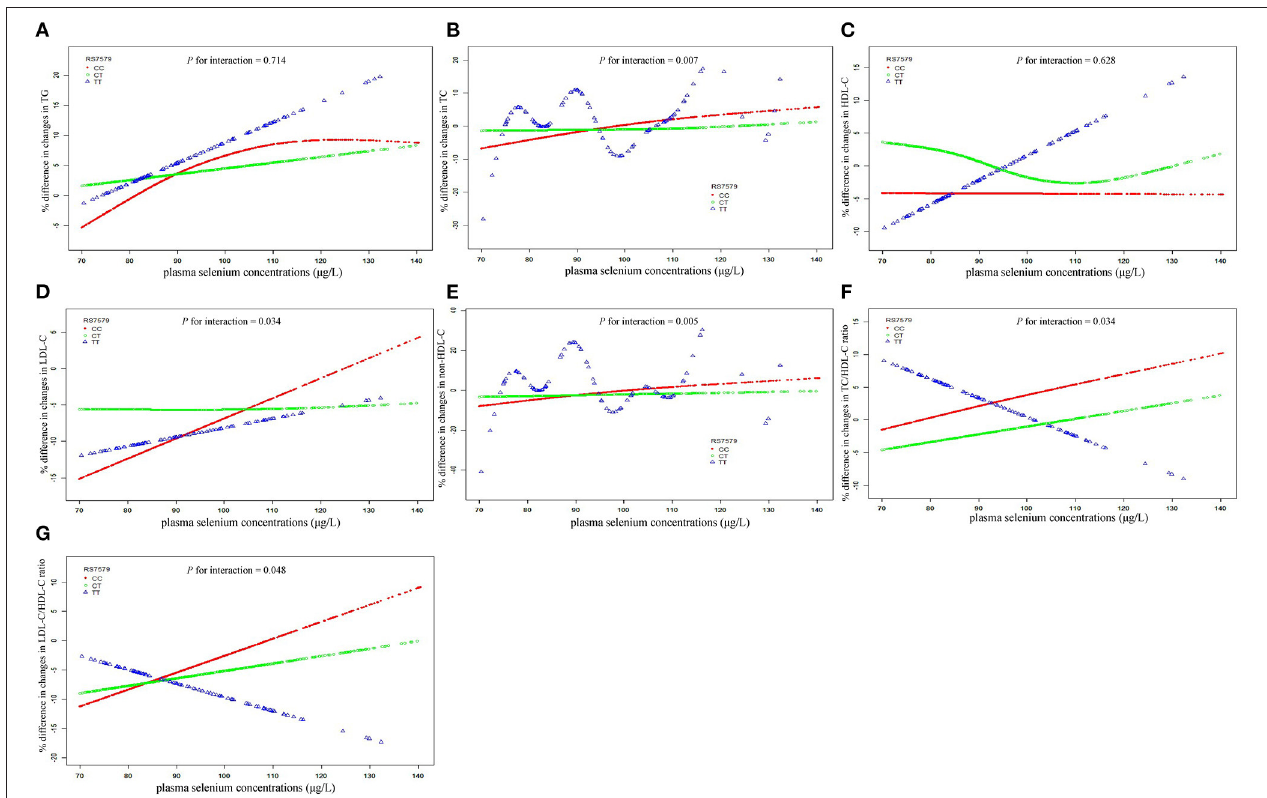
FIGURE 1 | Associations of plasma selenium concentrations with 3-year changes in lipids stratified by rs7579 genotypes. X bars represent plasma selenium concentrations. Y bars represent mean % difference in 3-year changes in triglycerides for (A) , TC for (B) , HDL-C for (C) , LDL-C for (D) , non-HDL-C for (E) , TC/HDL-C ratio for (F) , and LDL-C/HDL-C ratio for (G) . Multivariable analyses were adjusted for sex (men/women), age (continuous), BMI (continuous), current smoking status (yes/no), current drinking status (yes/no), physical activity (yes/no), educational level (none or elementary school/middle school/high school or beyond), and respective baseline lipid (continuous). BMI, body mass index; HDL-C, high-density lipoprotein cholesterol; LDL-C, low-density lipoprotein cholesterol; Non-HDL-C, non-high-density lipoprotein cholesterol; TC, total